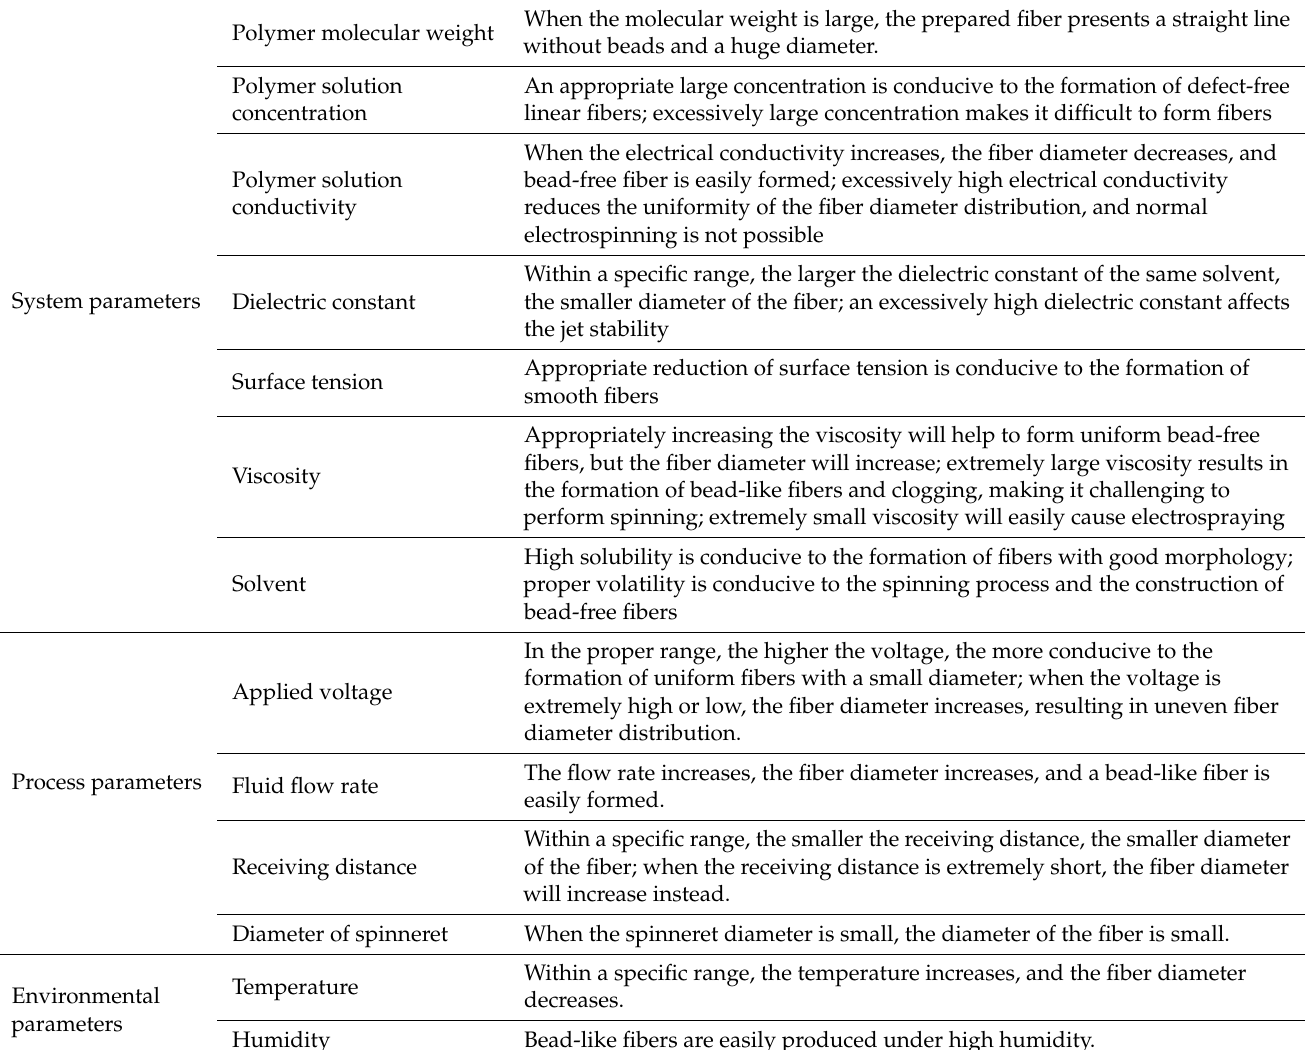
Table 2. Effect of three parameters on the morphology of electrospun fiber membrane.